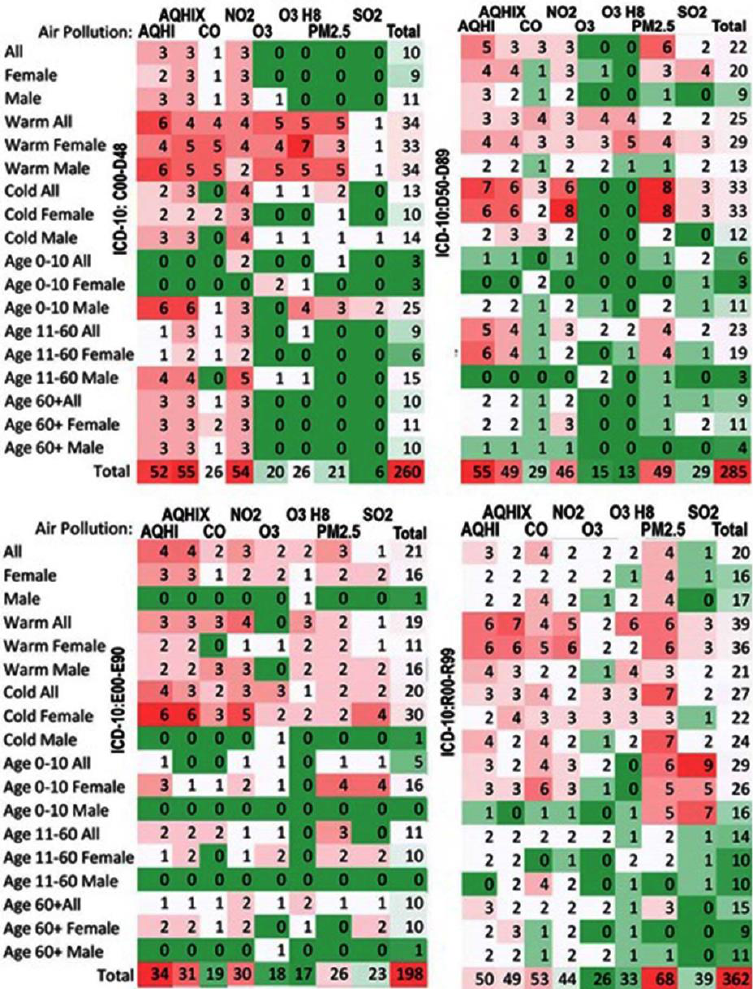
Figure 2. Frequencies of the numbers of positive statistically significant ( p -value < 0.05) associations